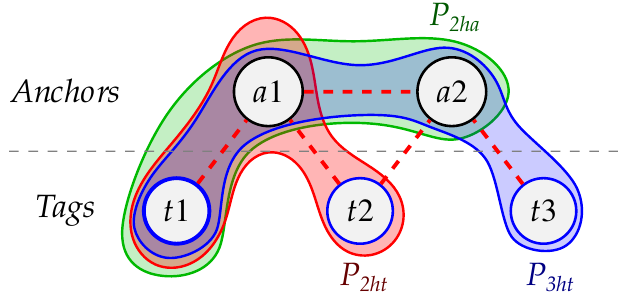
Figure 9. Augmented interference graph for reserved tag t